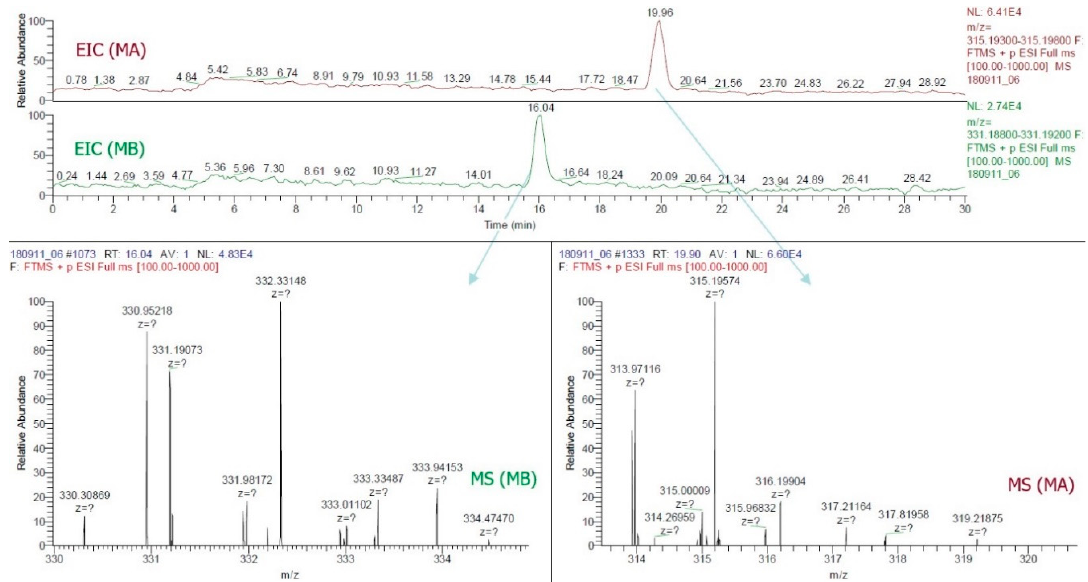
Figure 4. Extracted ion chromatograms and mass spectra of momilactones A and B detected in rice grain.